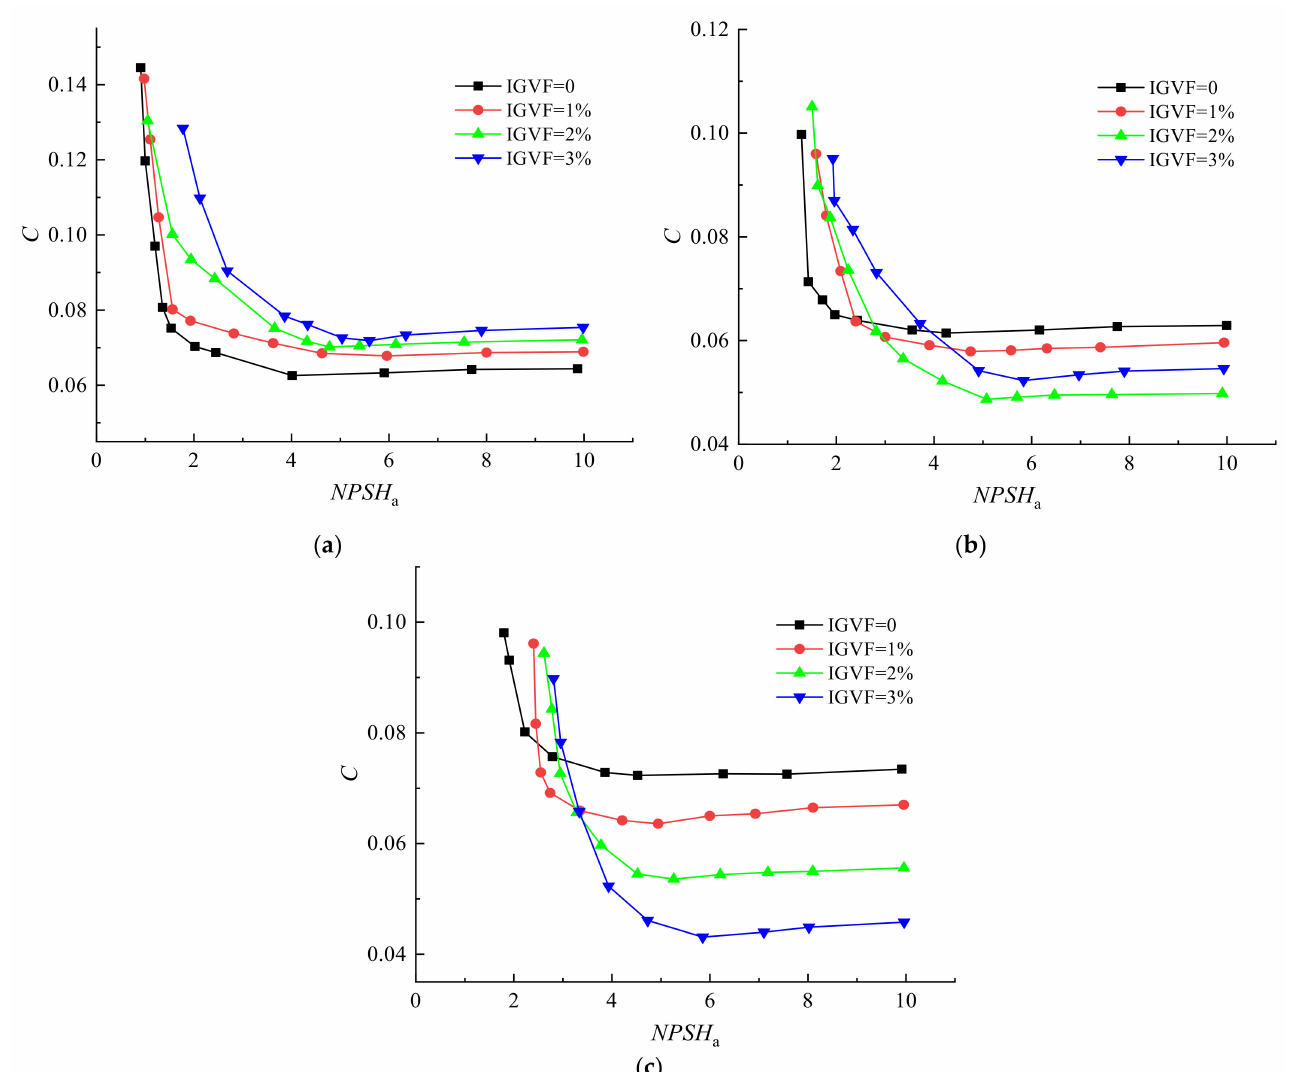
Figure 6. Pressure pulsation intensity of the model pump under different IGVF conditions and different flow rates: ( a ) 0.75 Q ld ( b ) 1.0 Q ld and ( c ) 1.25 Q ld